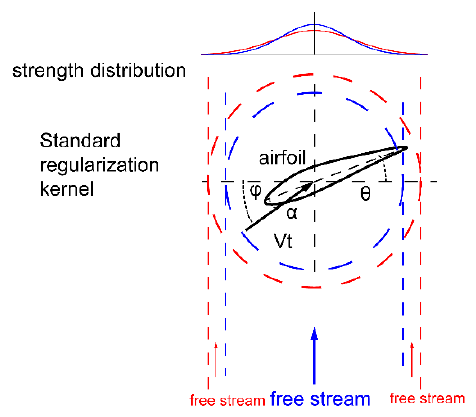
Figure 14. An illustration of the effective region of different ϵ value. The red one represents a regularization kernel with larger Gaussian width.